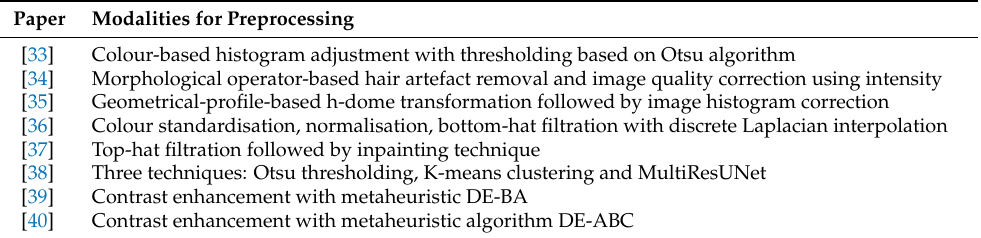
Table 1. Summary of preprocessing used in some boundary estimation procedures.